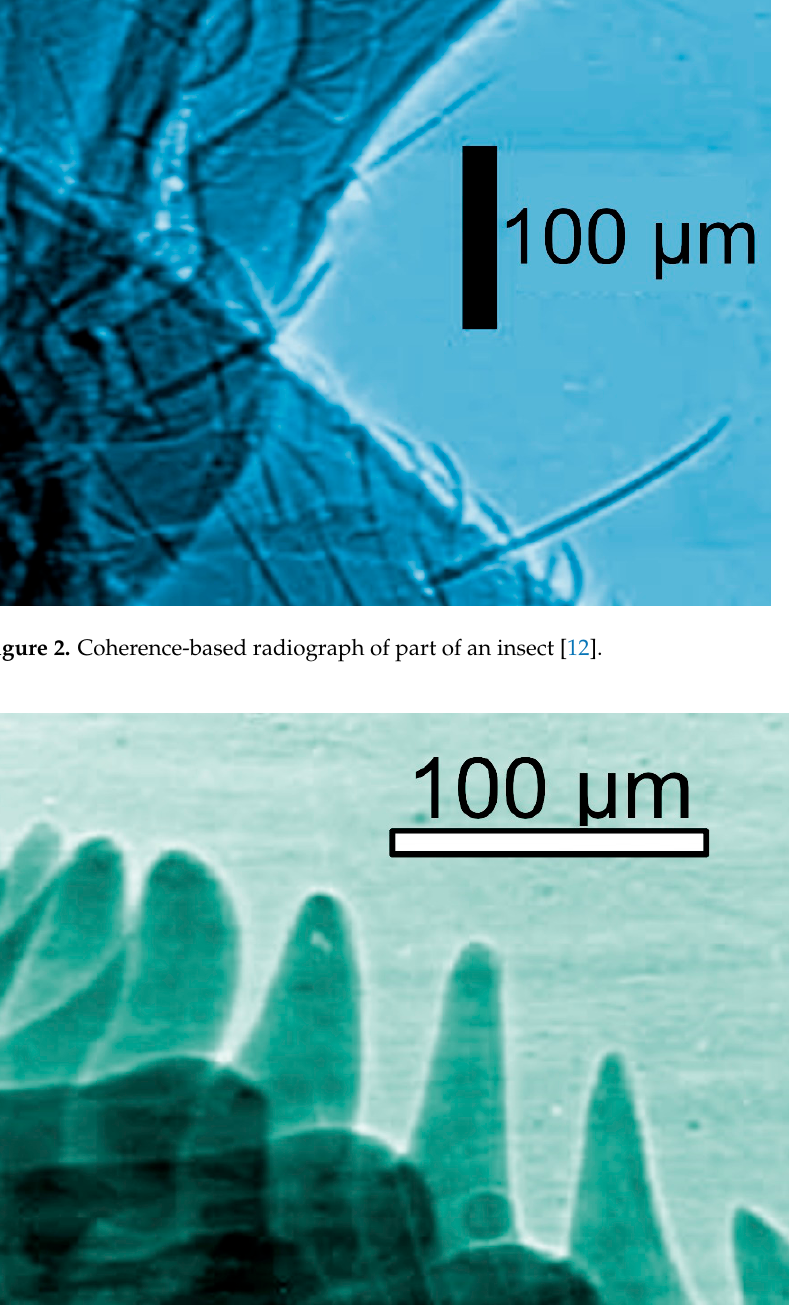
Figure 3. Coherence-based radiography can be also applied to live objects, such as small fish [12].